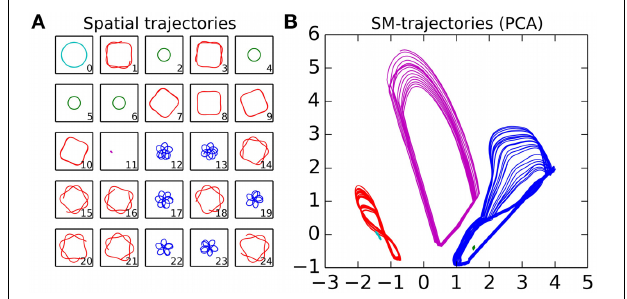
FIGURE 8 | Spatial and sensorimotor trajectories of habits that have emerged from a randomly initialized IDSM. The spatial plots (Plot A ) indicate the spatial trajectories taken by the agent during the last 25% of the trial indicated in the lower right corner. Plot (B) shows a PCA dimensional reduction projection of the sensorimotor trajectories for these same trajectories, with colors used to group those trials that have a similar spatial